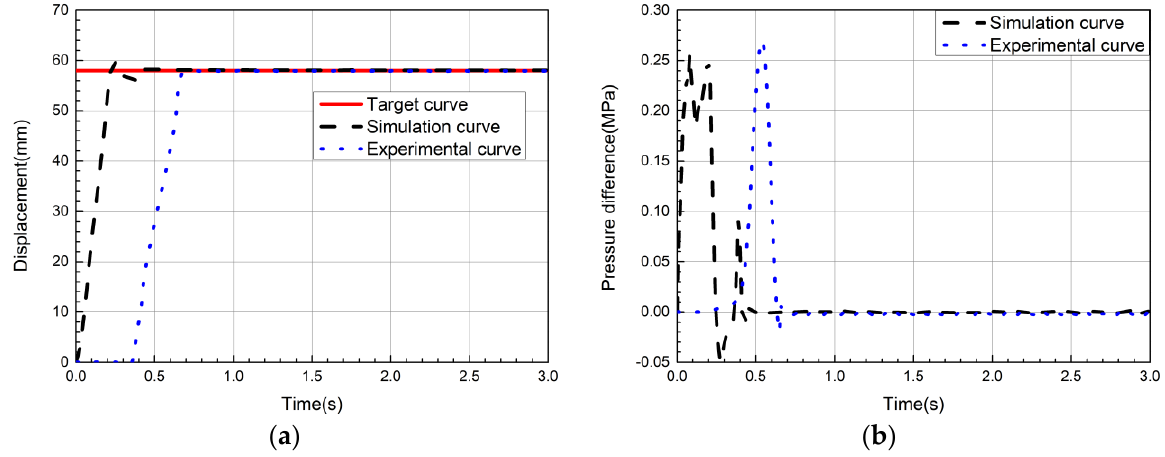
Figure 19. Step signal position control graph: ( a ) displacement graph; ( b ) differential graph.